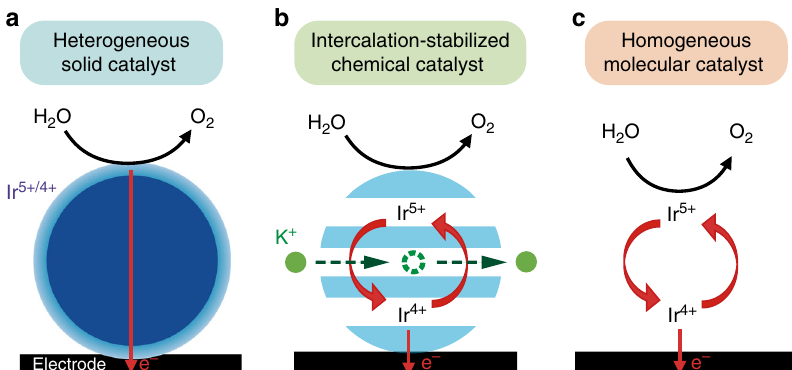
Fig. 1 Charge compensated chemical oxidation of water. Schematic illustration of a heterogeneous OER process on the surface of solid catalysts, b the OER proceeding on the surface of a solid catalysts with the bulk of the catalyst being redox-active accepting cations from the electrolyte upon OER, and c homogeneous catalysis with soluble molecular